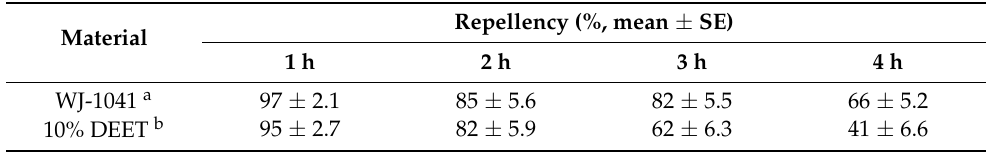
Table 9. Repellency of WJ-104 containing 10% veratraldehyde as an active ingredient against Haema- physalis longicornis nymphs using a filter paper